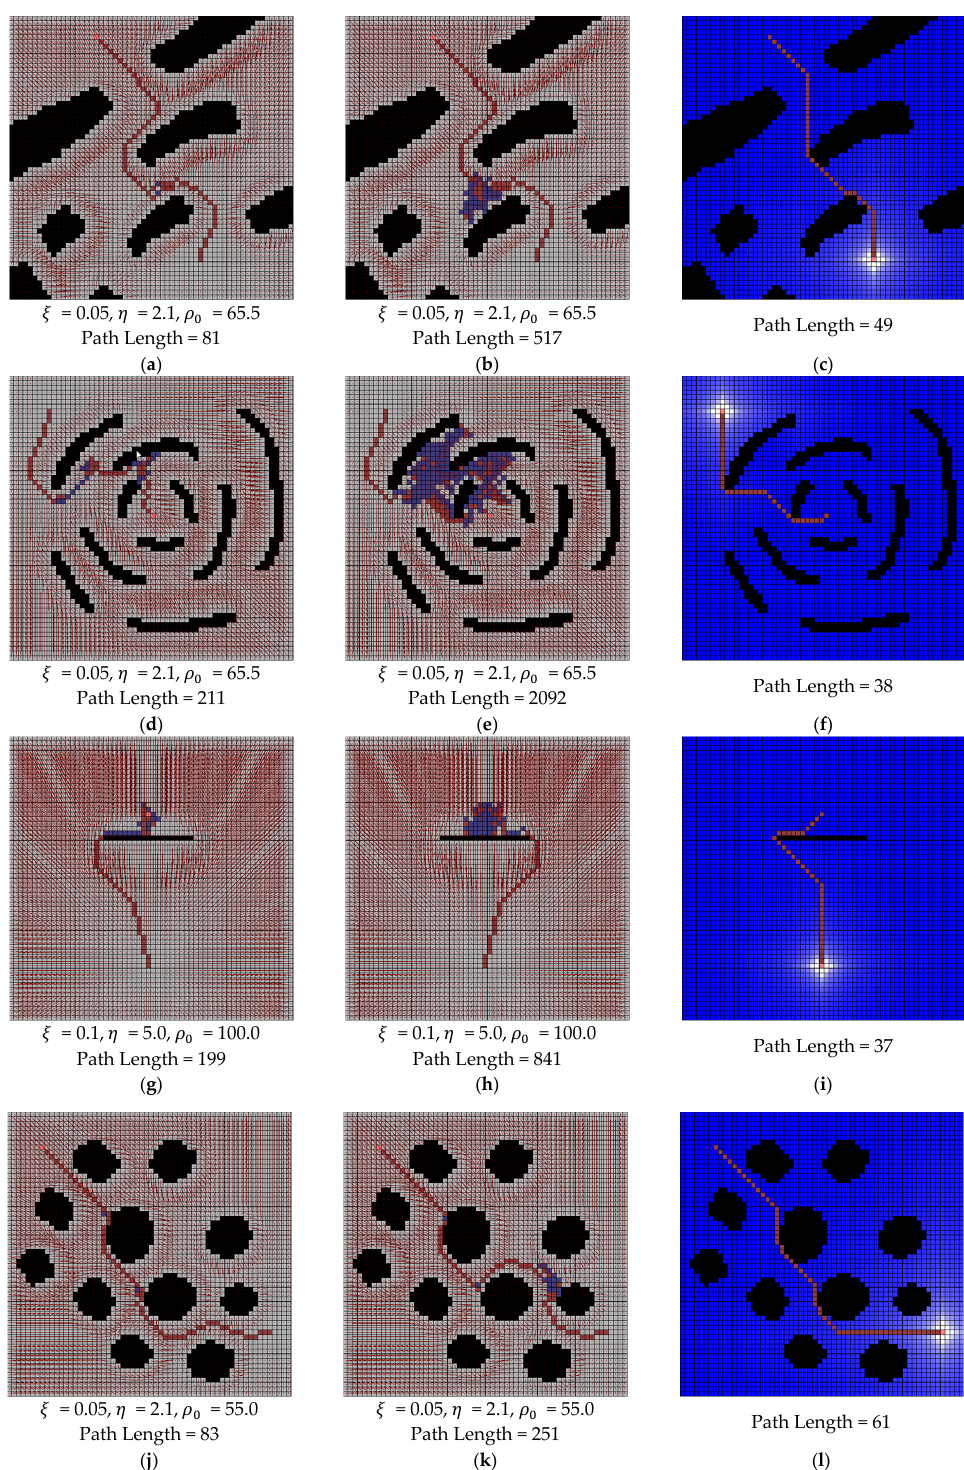
Figure 21. The results of comparison between water sink model and potential field with random walk: ( a , b , d , e ) parameters are 𝜉 = 0.05 , 𝜂 = 2.1 and 𝜌 (cid:2868) = 65.5 ; ( g , h ) parameters are 𝜉 = 0.1 , 𝜂 = 5.0 and 𝜌 (cid:2868) = 100.0 ; ( j , k ) parameters are 𝜉 = 0.05 , 𝜂 = 2.1 and 𝜌 (cid:2868) = 55.0 ; ( c , f , i,l ) are the results of water sink model.